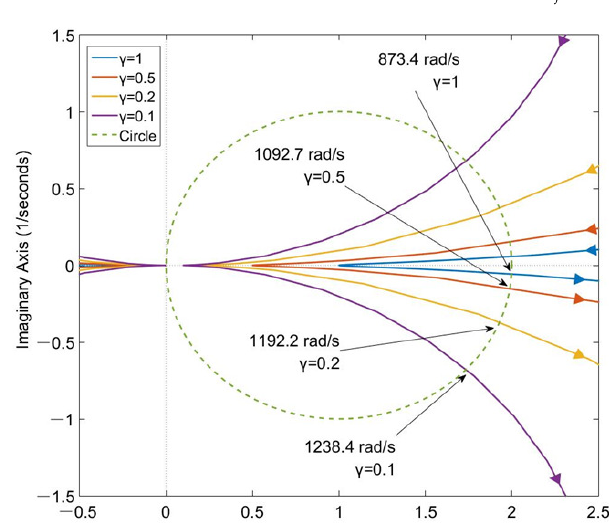
Figure 6. Nyquist plot of γ · e j · ω · t s · G ( e j · ω · t s ) with different γ